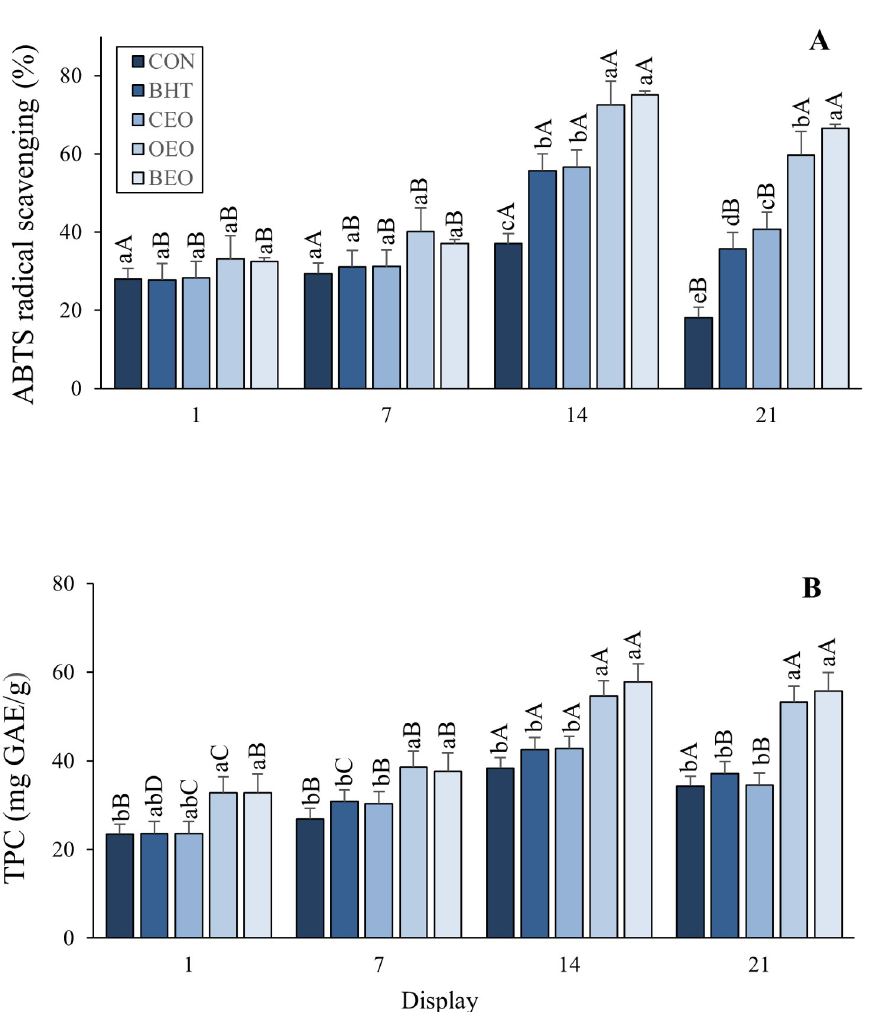
Fig 1. Evolution of antioxidant activity ABTS and total phenolic compounds in beef patties treated with BHT, copaiba and oregano essential oil or blend of essential oils during display.